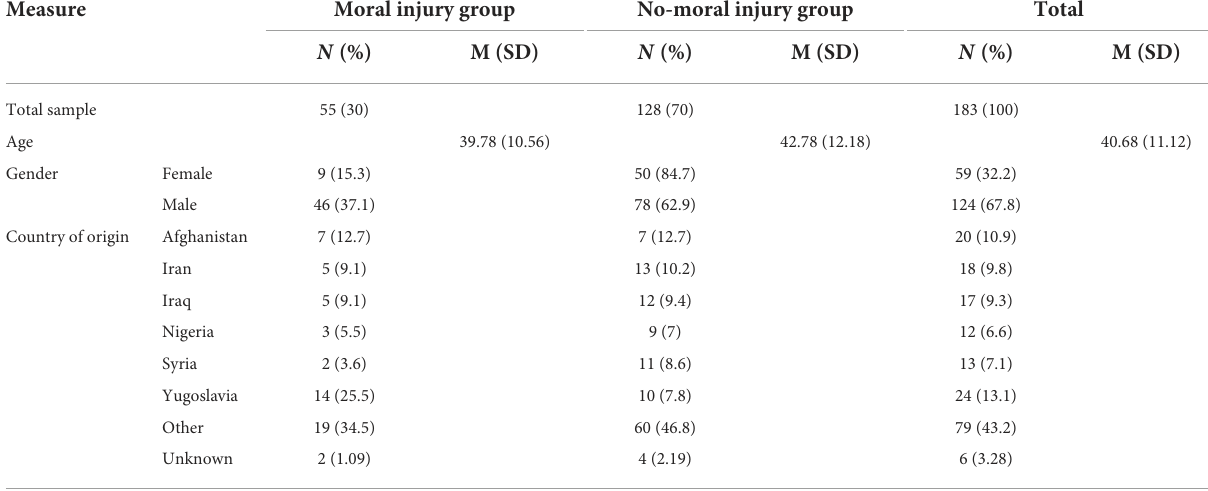
TABLE 1 Descriptive statistics of demographic variables for each group.